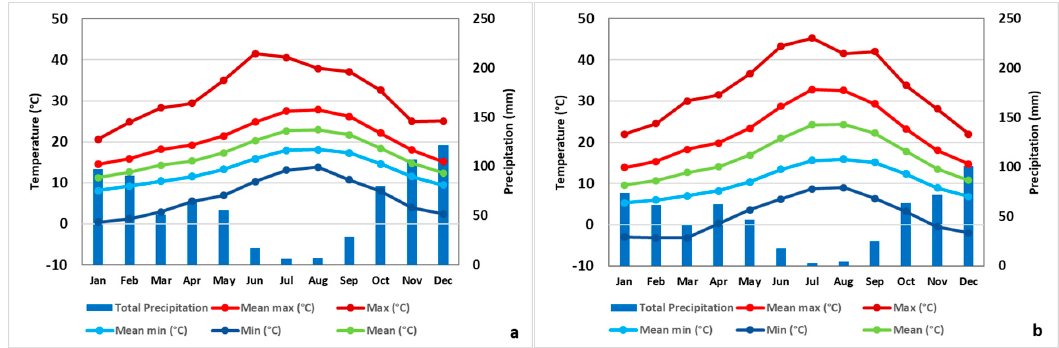
Figure 1. Thirty-year (1971–2000) average temperature and precipitation for ( a ) case study I—Lezíria do Tejo and ( b ) case study